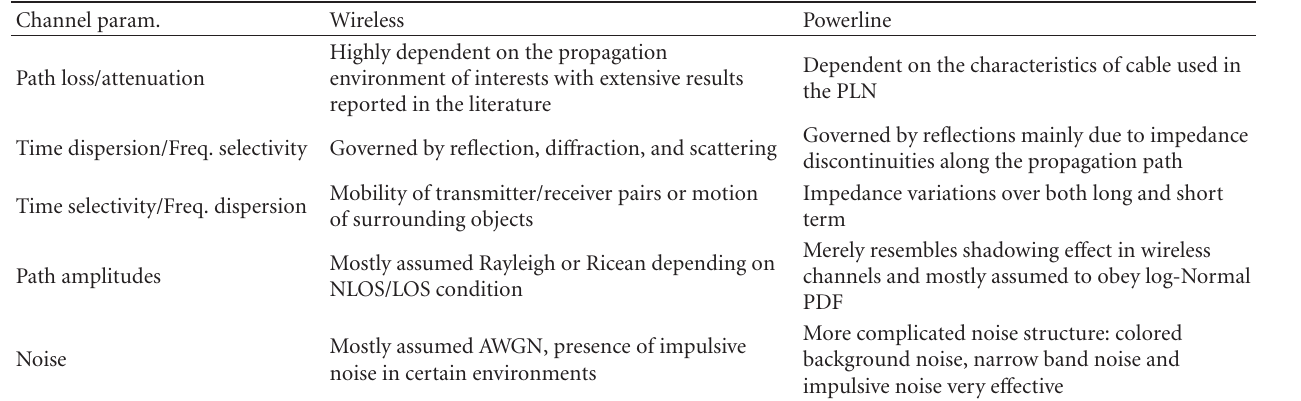
Table 2: Outline of wireless and PLC channel